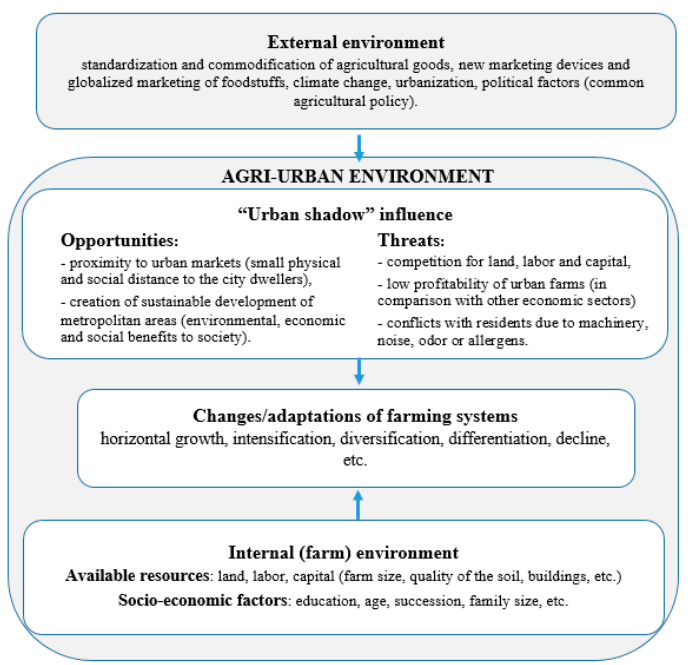
Figure 1. Conceptual framework of external and internal forces shaping farming systems. Source: own elaboration.